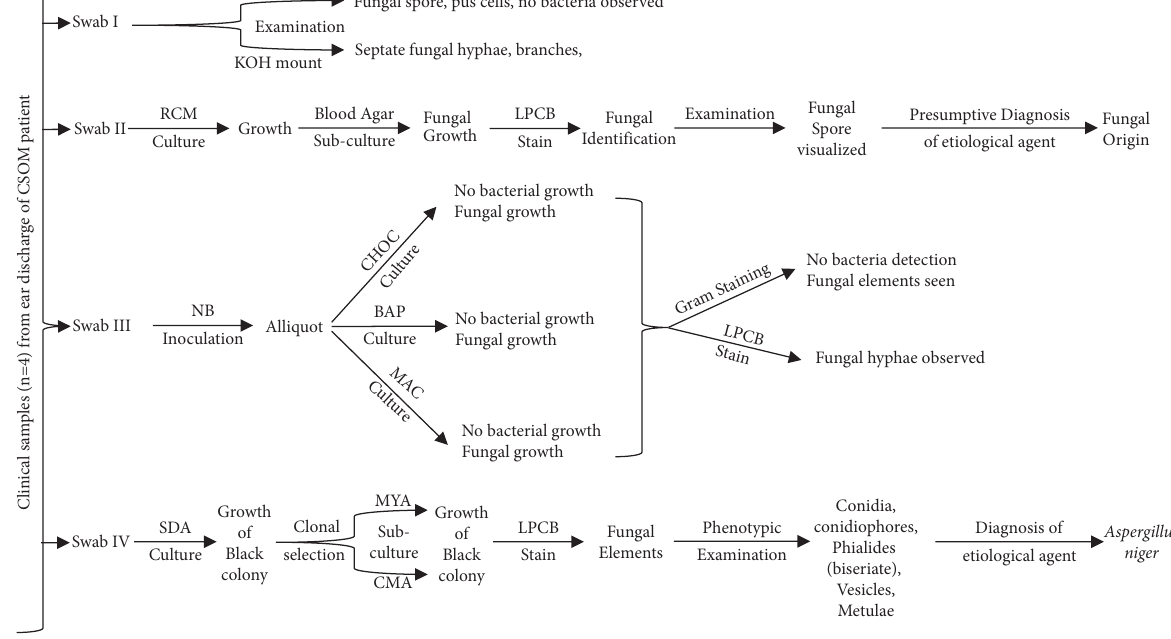
Figure 6: Flowchart showing overall laboratory investigation assessments and result outcomes in this